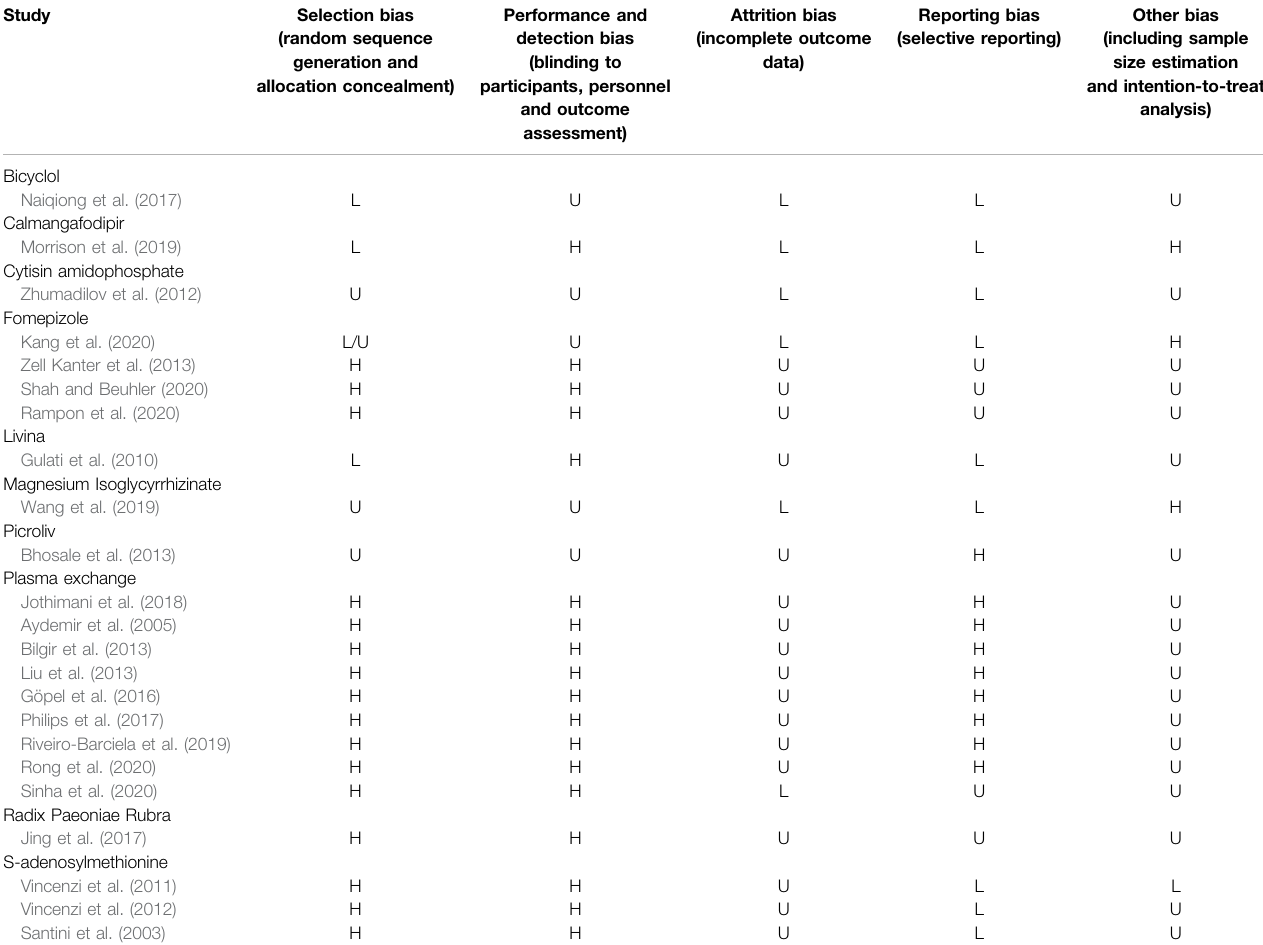
TABLE 3 | Risk of bias across included